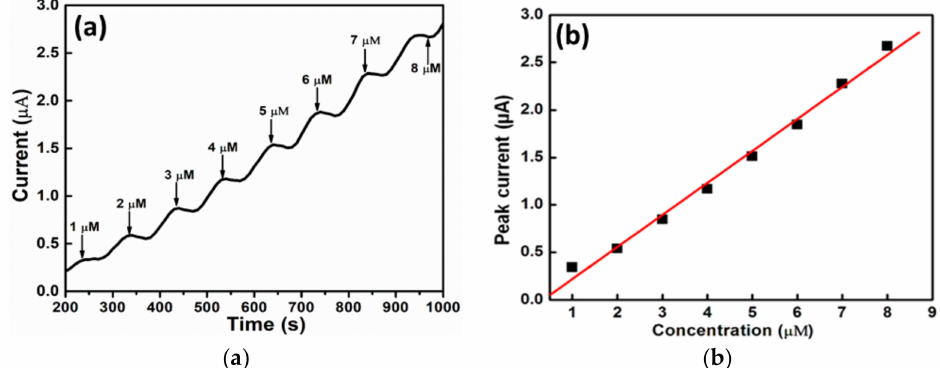
Figure 6. ( a ) Amperometric response of the Gd 2 O 3 / Au electrode with an increase in the concentration of hydrazine and ( b ) respective peak current vs. concentration plot of hydrazine in PBS at pH = 7.